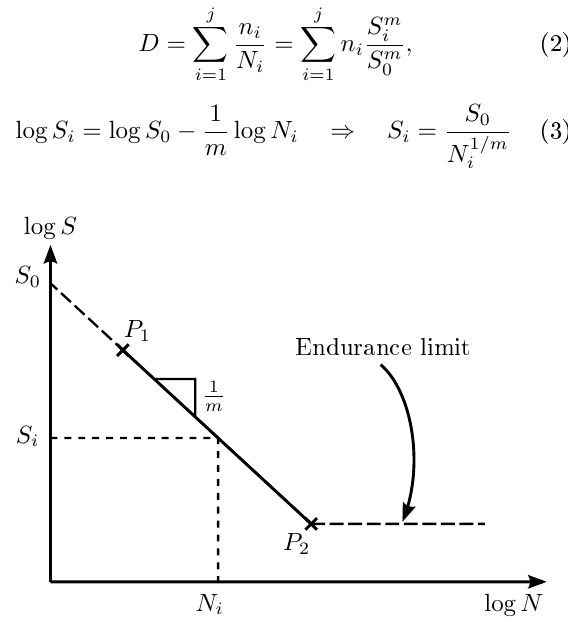
Figure 4: S(cid:21)N-curve for fatigue